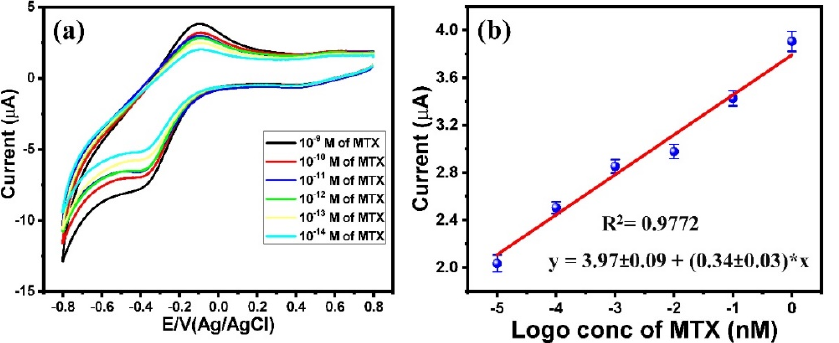
Figure 6. ( a ) Cyclic voltammetry of MTX using P4d/Fe 3 O 4 /ITO electrode at different concentration ranges from 10 − 9 to 10 − 14 M MTX in PBS buffer pH = 7.4, scan rate = 0.05 V/s; ( b ) the calibration curve for the oxidation peak and the MTX concentrations.